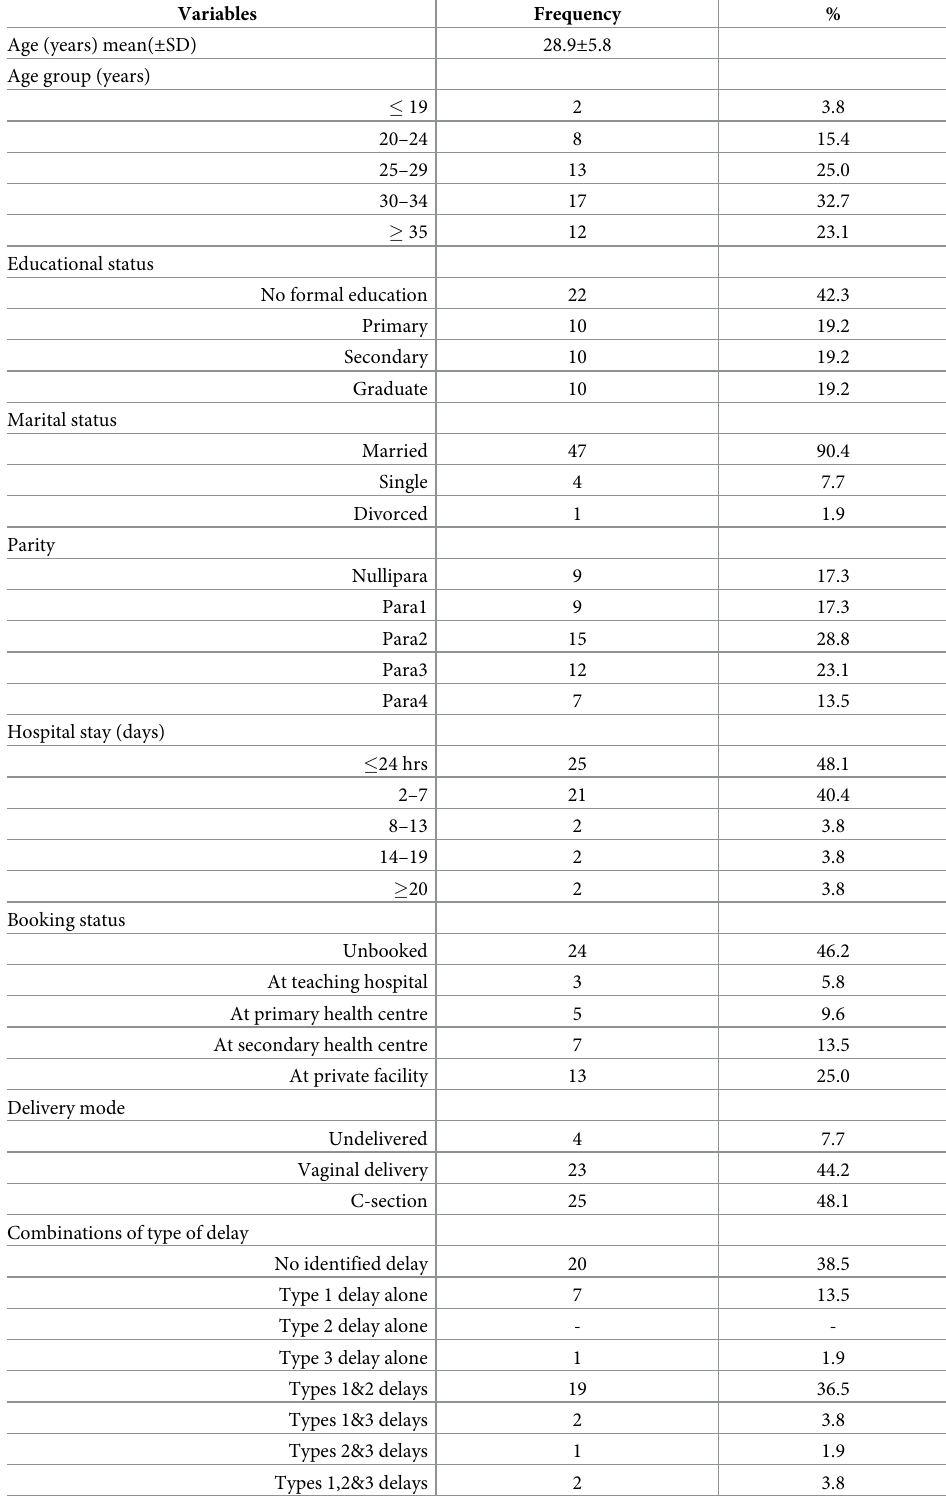
Table 1. Socio-demographic characteristics of cases of maternal deaths at University of Abuja Teaching Hospital, Abuja, Nigeria, 2014–2018 (n =